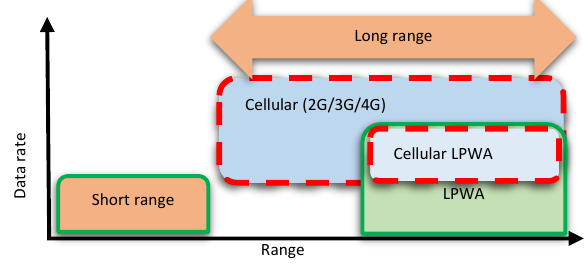
Figure 7 : Required data rate vs. range